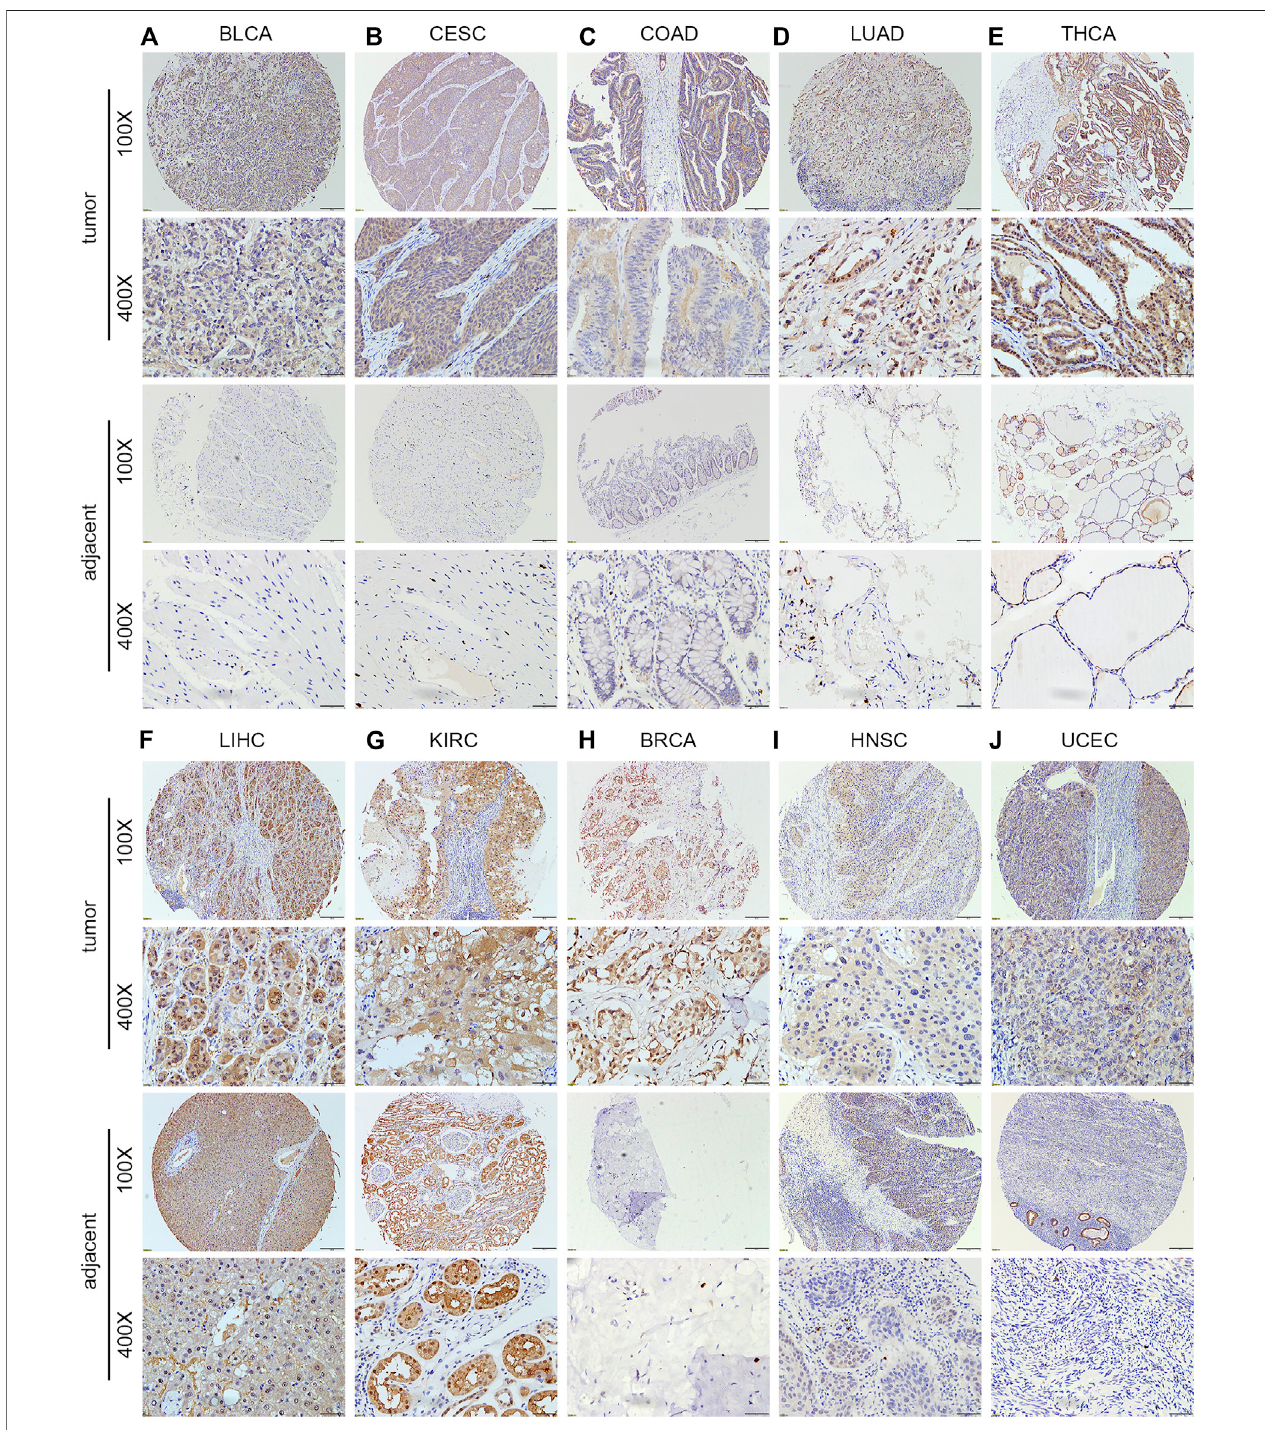
FIGURE2| Proteinexpression levelofPNPOinhumanmultiplecancertissues ofBLCA (A) ,CESC (B) ,COAD (C) ,LUAD (D) ,THCA (E) ,LIHC (F) ,KIRC (G) ,ESCA (H) , LUSC (I) , and TGCT (J) . Representative images of PNPO expression in pan-cancer tissues are shown. Original magni fi cation, × 100 and × 400.